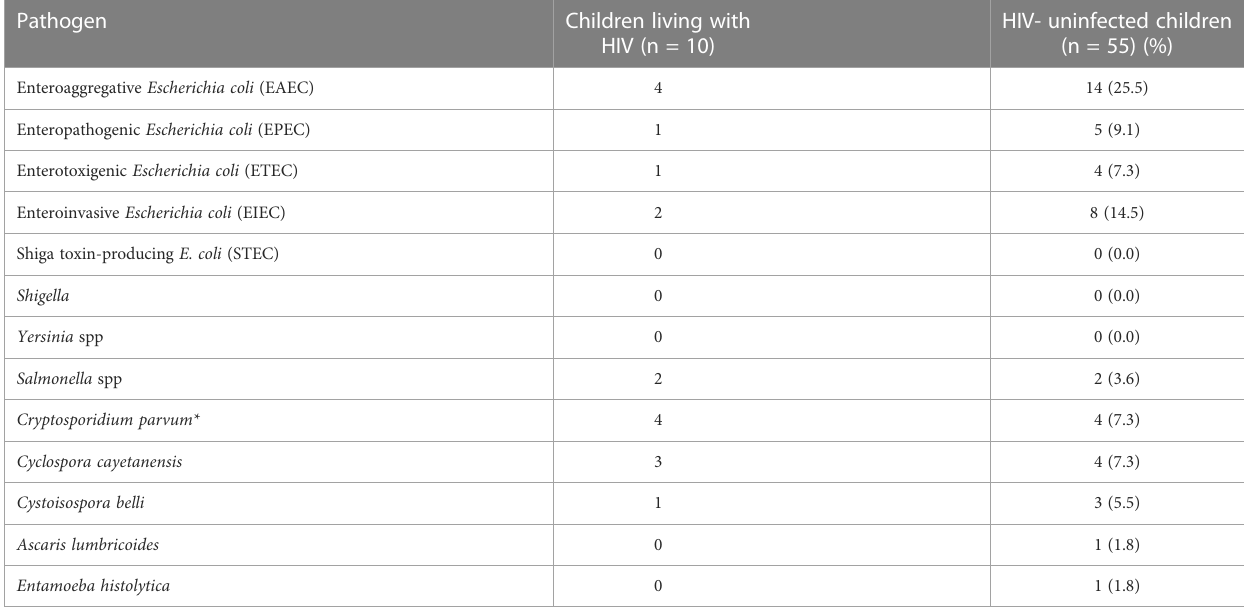
TABLE 2 Detection of pathogens in the stools of children living with HIV and HIV-uninfected children with diarrhea.